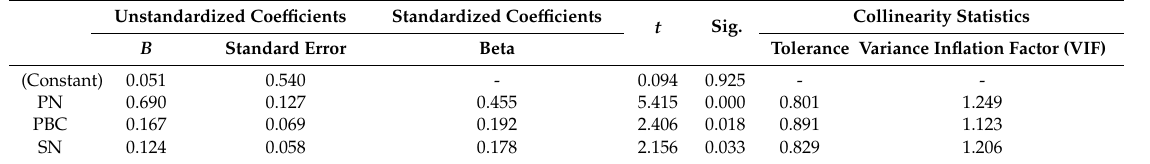
Table 17. Final results of the statistical significance